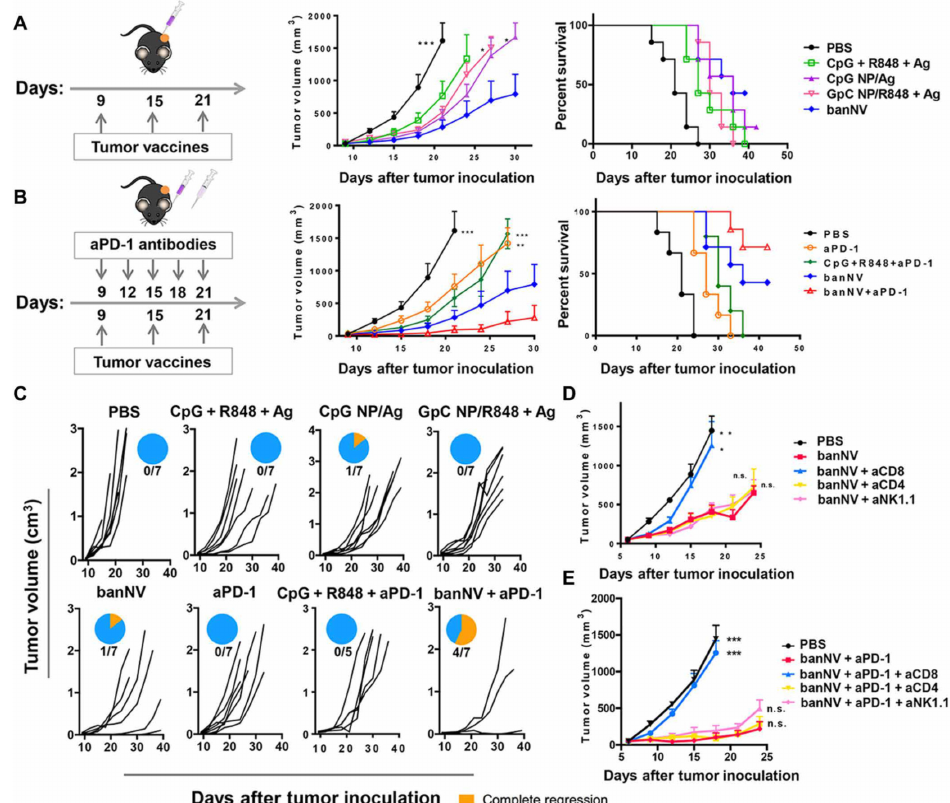
Figure 3. Combination of banNVs with immune checkpoint blockade markedly promotes response and complete regression of MC38 tumors in syngeneic mice: ( A ) Left: Experimental design for tumor immunotherapy in C57BL/6 mice with the indicated formulations of vaccines; middle: tumor growth curve, and right: mouse survival of C57BL/6 mice after subcutaneous inoculation with MC38 tumor cells. ( B ) Left: Experimental design for combination tumor immunotherapy in C57BL/6 mice with banNVs and anti PD-1; middle: tumor growth curve; and right: mouse survival of C57BL/6 mice after subcutaneous inoculation with MC38 tumor cells. ( C ) Individual tumor growth and survival profiles of C57BL/6 mice treated with vaccines and/or anti PD-1 over 40 days. ( D , E ) Tumor growth curve after vaccination with banNVs or the combination of banNV and anti PD-1, together with lymphocyte depletion by anti-CD8, anti-CD4 or anti-NK1.1. Reproduced from reference [113] without changes. * p < 0.05, ** p < 0.01, and *** p <